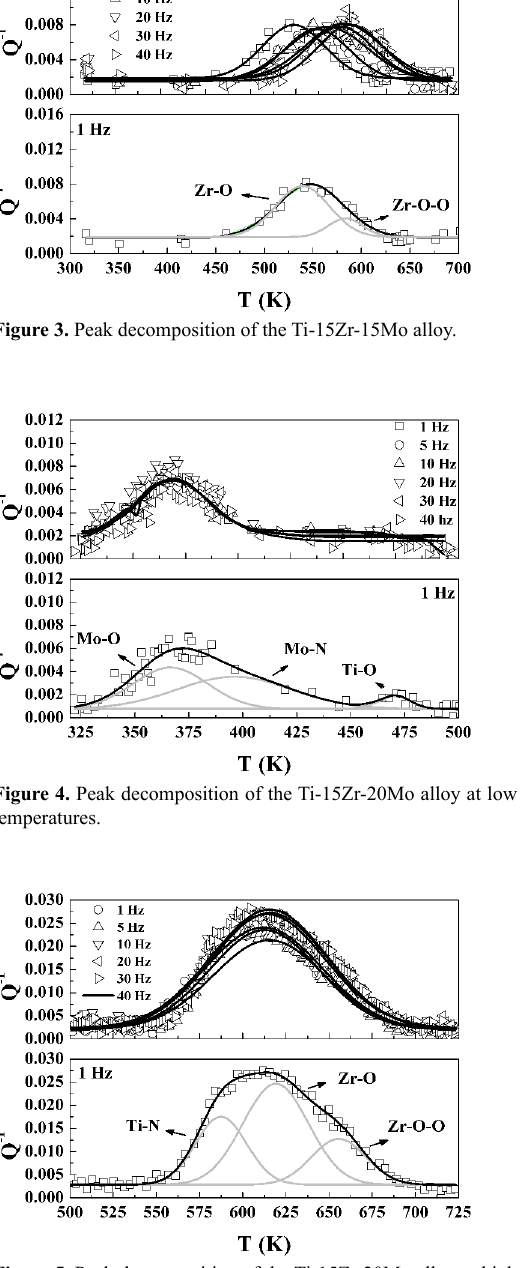
Figure 5. Peak decomposition of the Ti-15Zr-20Mo alloy at high